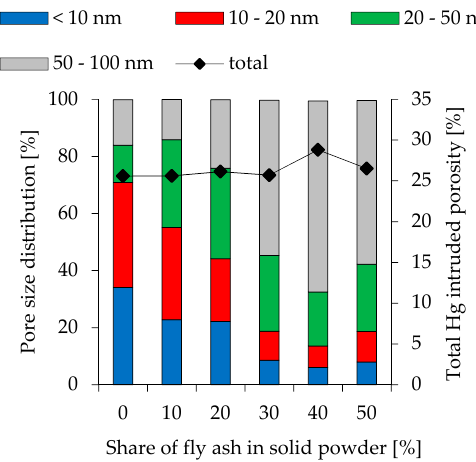
Figure 9. Pore size distribution of geopolymers cured for 28 days (l / s 0.54).